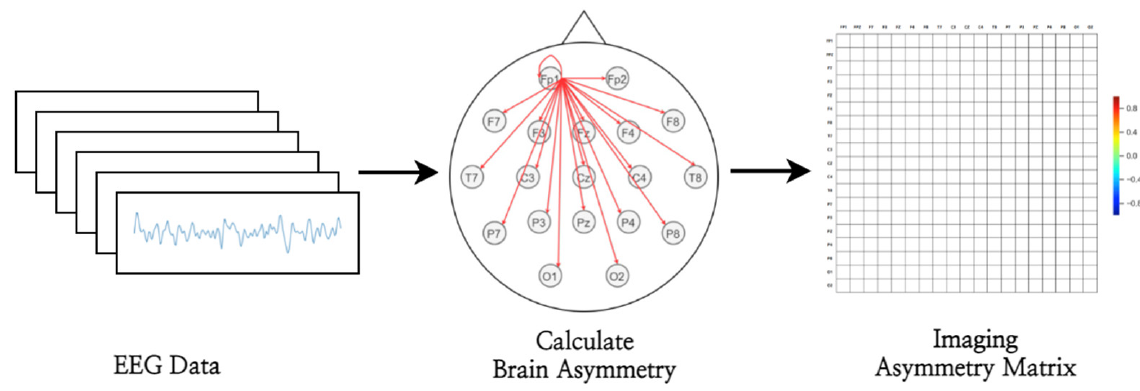
Figure 2. Deep-asymmetry imaging method.